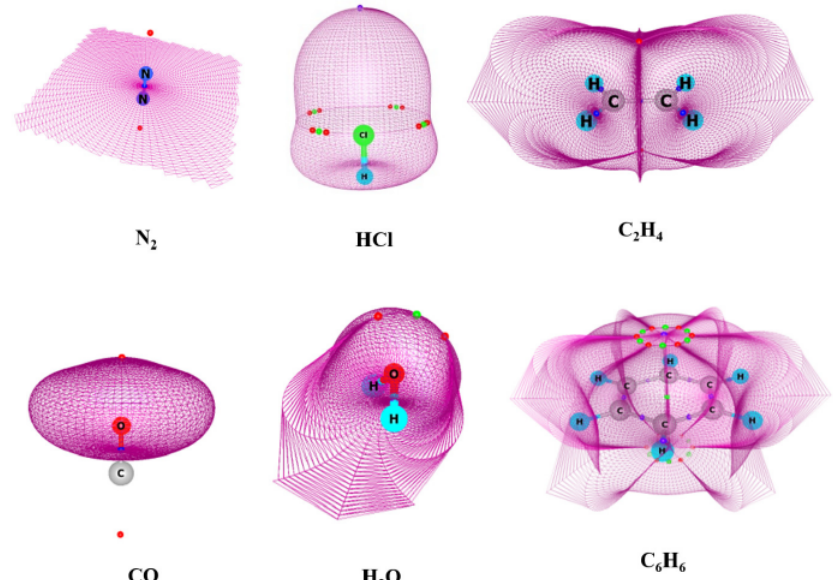
Figure 7. MESP-based ZFS surfaces of N 2 , HCl, CO, C 2 H 4 , H 2 O and C 6 H 6 NH 3 BH 3 employing B3LYP/6-311G (d, p) calculations. Color-coded dots for CPs are: red (3, +3), green (3, +1) and blue (3, − 1). See text for